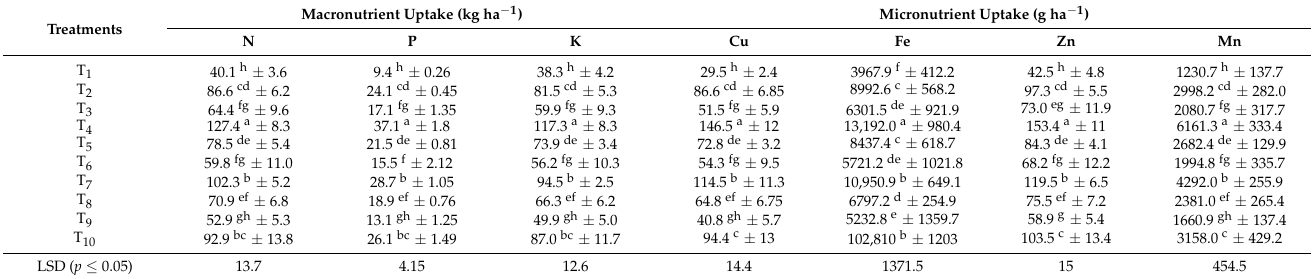
Table 4. Effects of panchagavya, jeevamrut, and organic manures on nutrient uptake by plants.